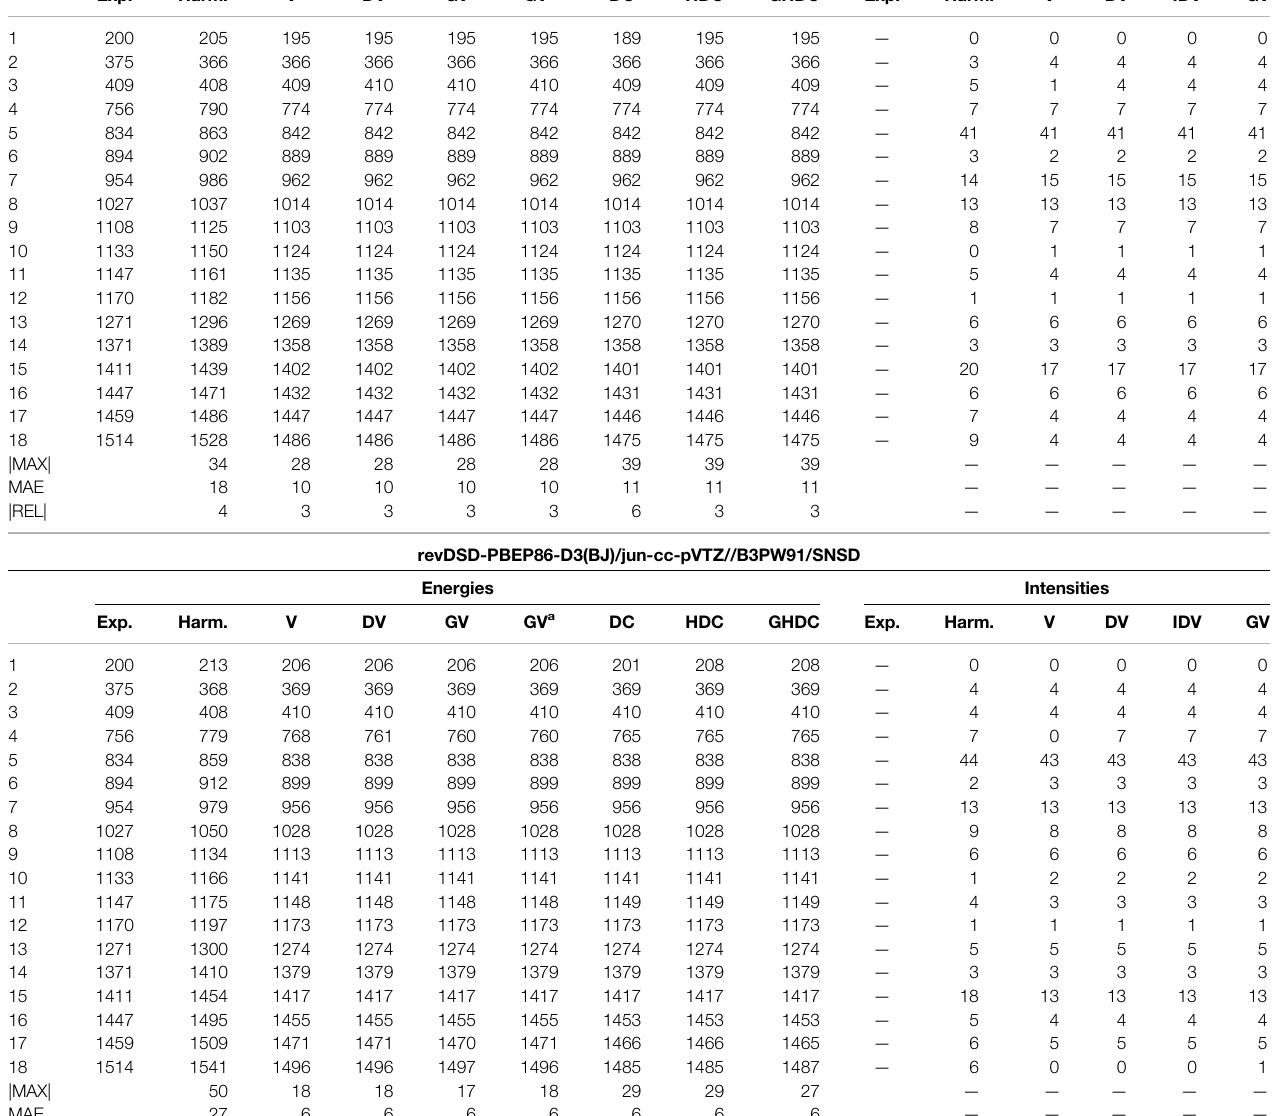
TABLE 6 | Harmonic and anharmonic vibrational energies (in cm − 1 ) and intensities (km/mol) for the fi rst 18 modes (by increasing energy) of methyloxirane computed at the B3PW91/SNSD and hybrid revDSD-PBEP86-D3(BJ)/jun-cc-pVTZ//B3PW91/SNSD levels oftheory and with different VPT2 schemes. The maximum (|MAX|) and mean (MAE) absolute errors, as well as the maximum relative error weighted by the reference value (|REL|, given in %) are reported with respect to experimental data from (Polavarapu et al., 1985; Sunahori et al., 2010; Merten et al., 2013). B3PW91/SNSD Energies Intensities